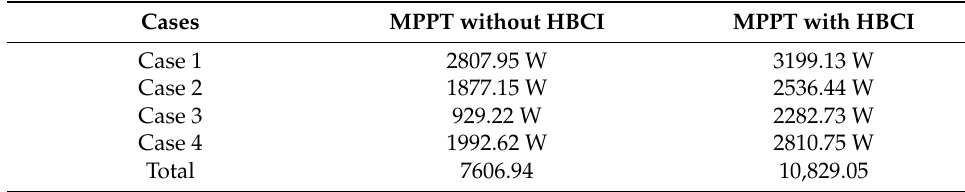
Table 6. Power comparison with and without